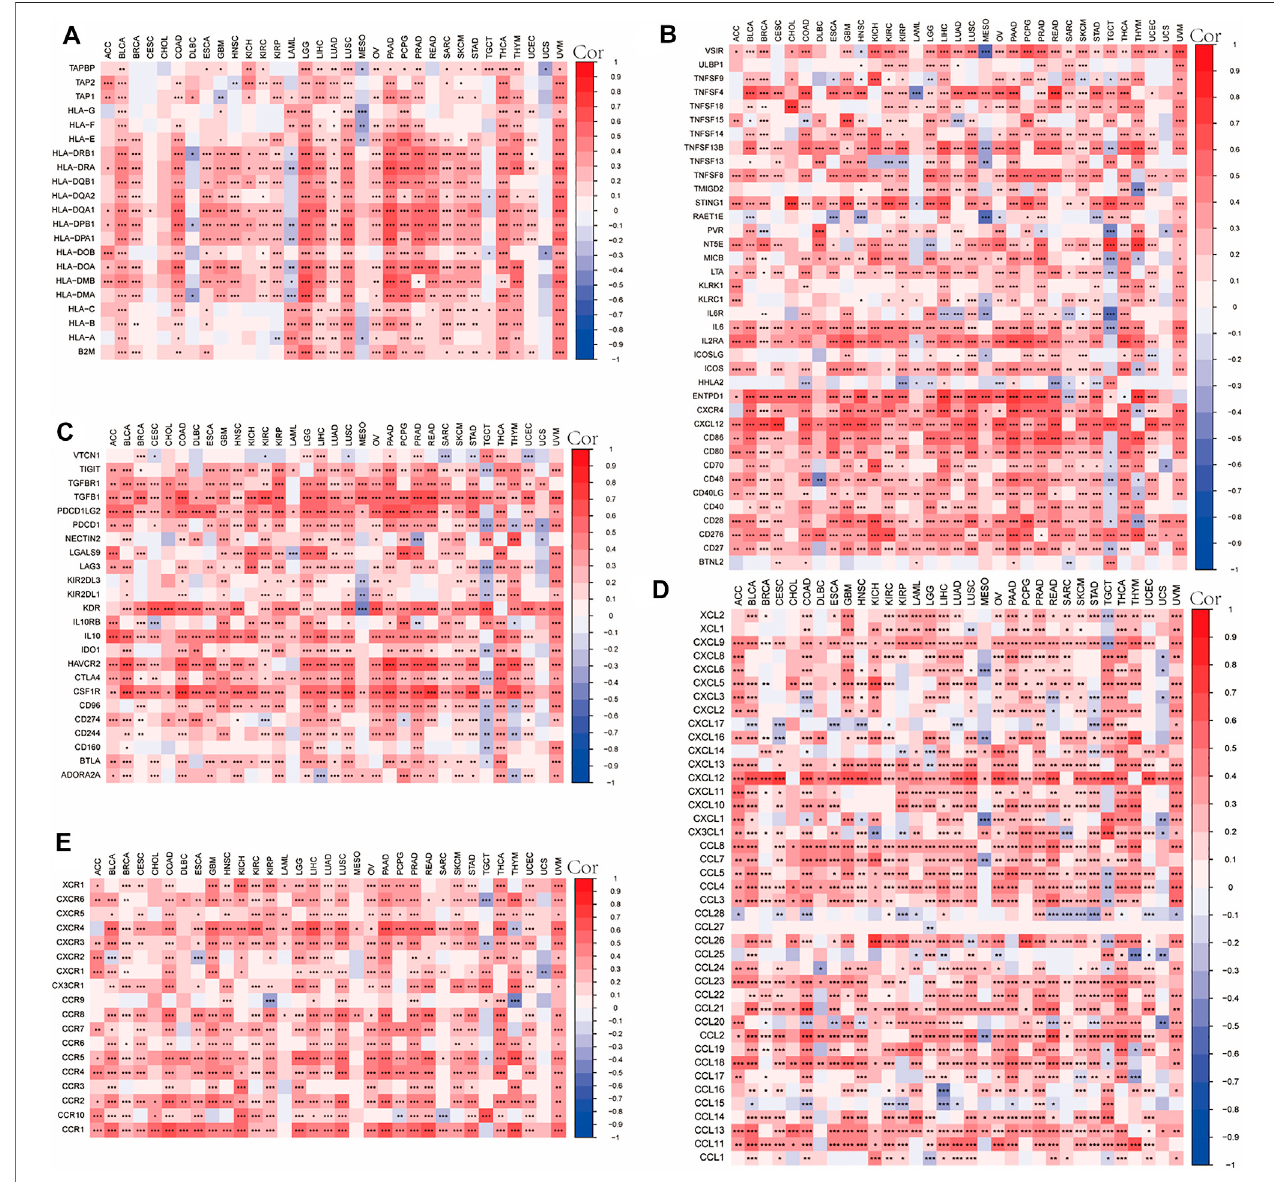
FIGURE 9 | Correlation between OLFML2B expression and immune-associated genes in pan-cancer. (A) MHC genes heatmap. (B) Immune active genes heatmap. (C) Immunosuppressive genes heatmap. (D) Chemokine genes heatmap. (E) Chemokines receptor genes heatmap.